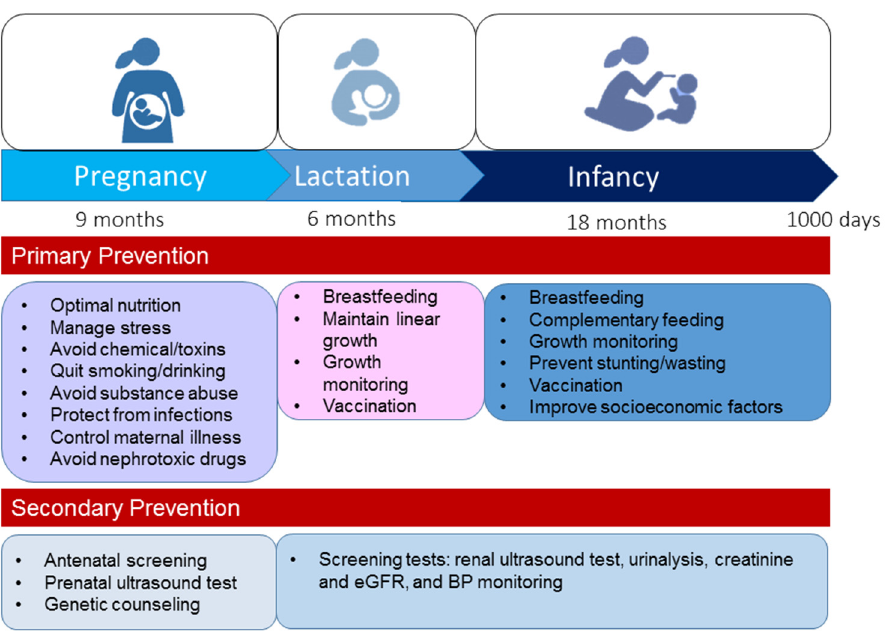
Figure 4. A summary of prevention strategies to improve kidney health during the first 1000 days of life.